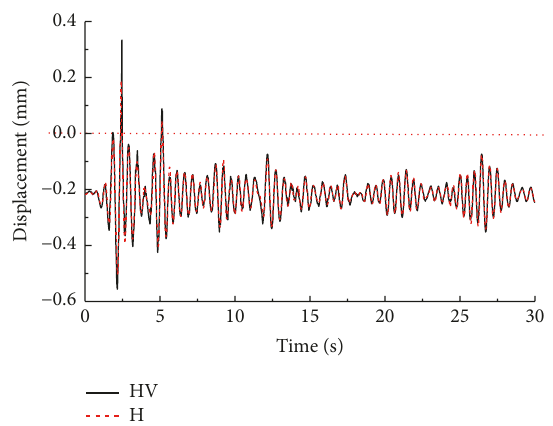
Figure18:Verticaldisplacementtimehistorycurvesatnode1under EL wave for H case and HV case.